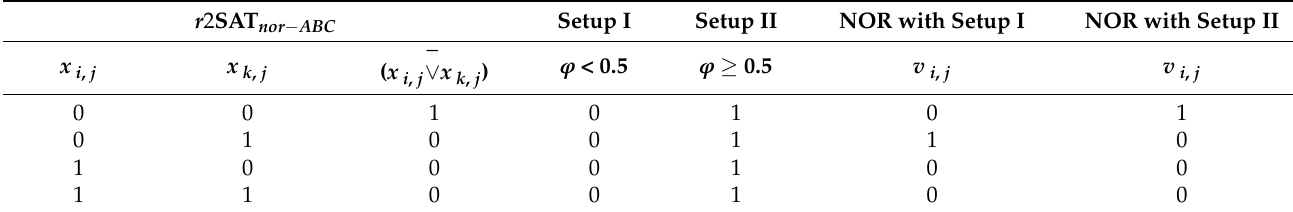
Table 11. The implication truth table for